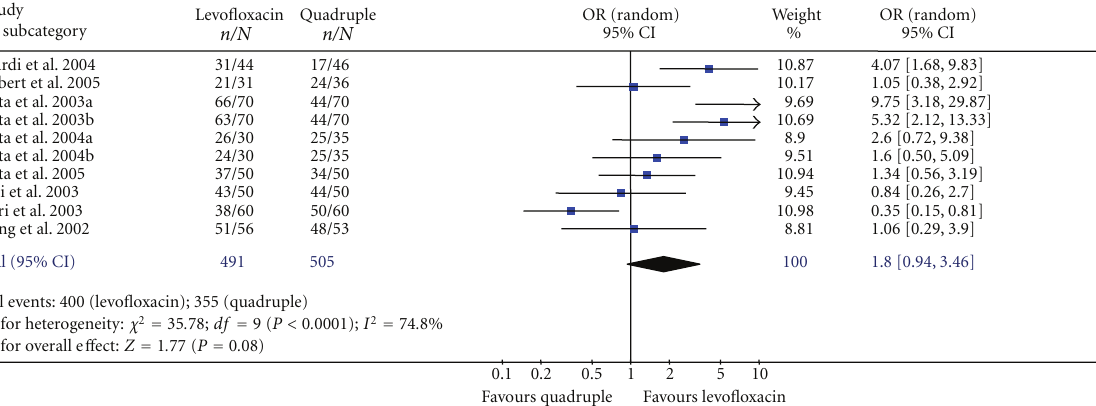
Figure 1: Meta-analysis comparing H. pylori eradication e ffi cacy with levofloxacin-based triple regimens versus quadruple therapy, as second-line “rescue” regimen after failure of a proton pump